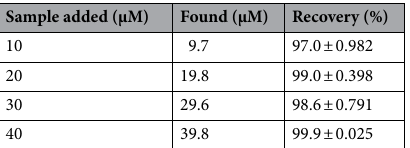
Table 2. Result of recoveries of ADR at Po-ERY/MGPE in an injection